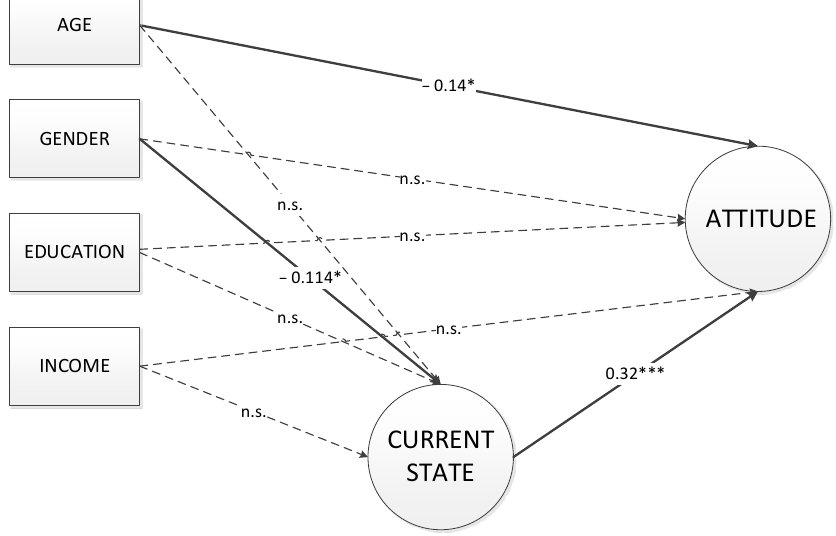
Figure 2. Estimated parameters along with corresponding statistical significance (Model Α). * pa- rameter is significant at the 10% significance level. n.s.: non-significant.